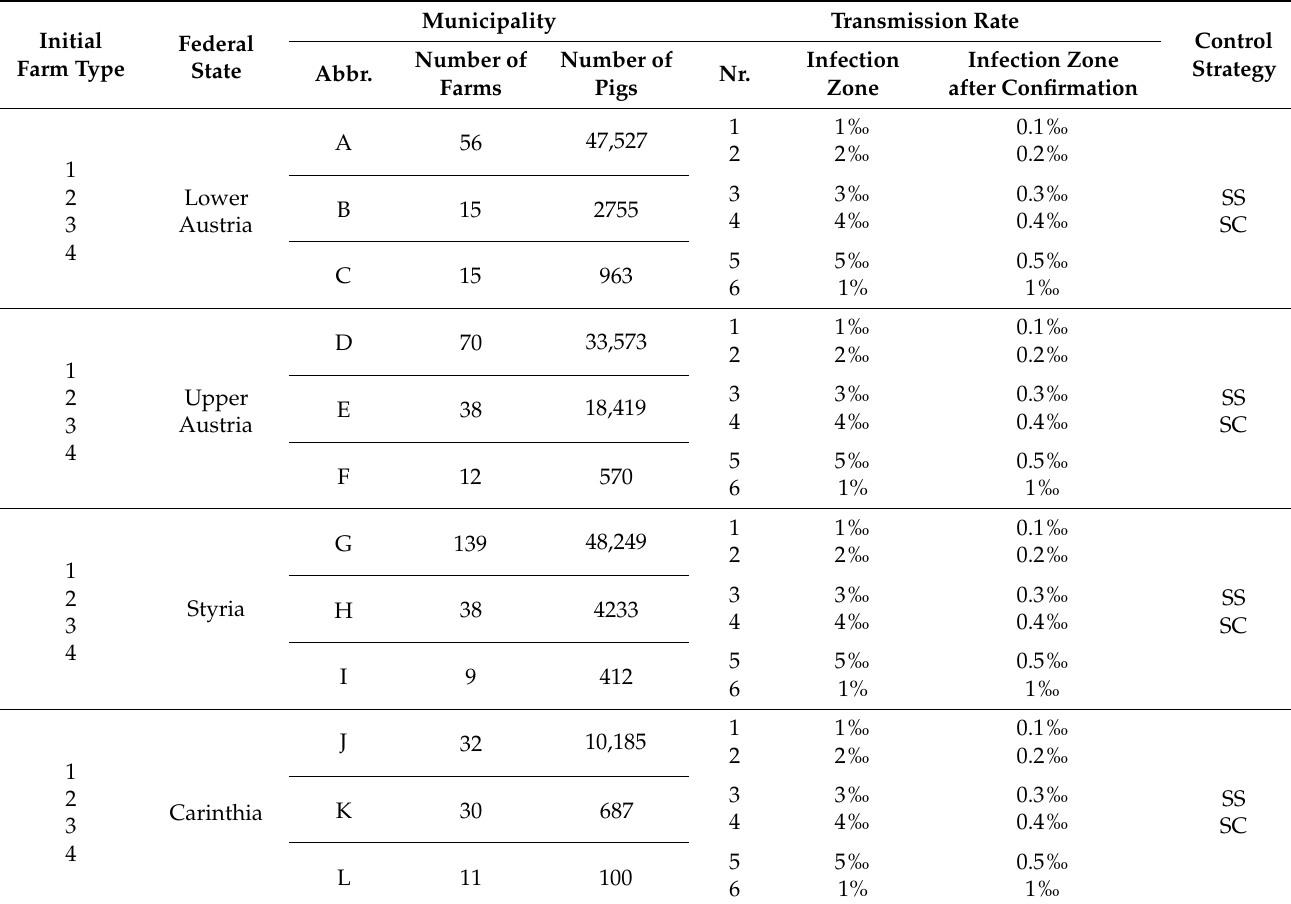
Table 3. Overview of the numerical studies and the included parameter